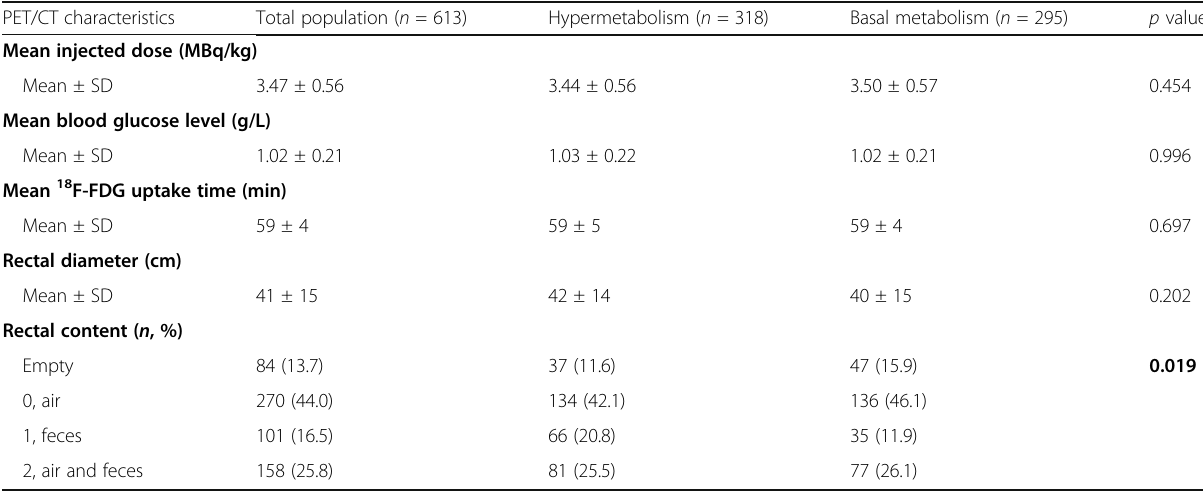
Table 3 PET/CT characteristics PET/CT